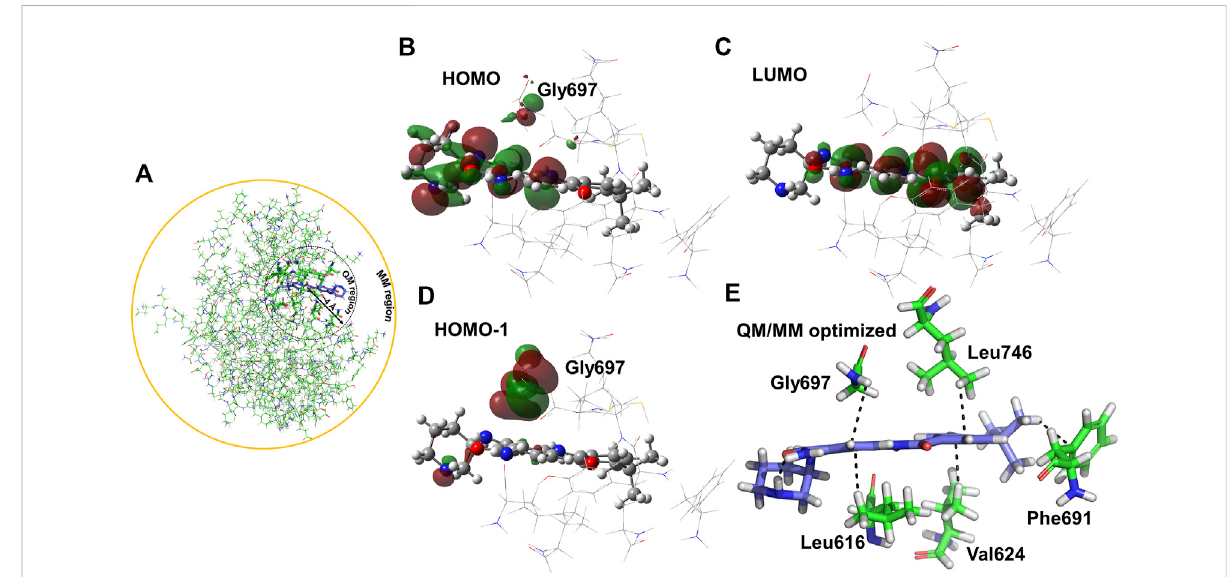
FIGURE 5 QM optimization of PCW-A1001 with FLT-3(D835Y). (A) Schematic representation of the QM and MM optimization region selected in the protein-ligand complex of the FLT-3-D835Y mutant. (B,D) HOMO/HOMO-1 surface of FLT-3 (D835Y) and (C) LUMO surface in FLT-3 (D835Y) in complex with PCW-A1001. Ligand PCW-A1001 shows in ball and sticks and the residues in the QM region shown in lines. (E) Hydrophobic interactions observed in the QM/MM optimized